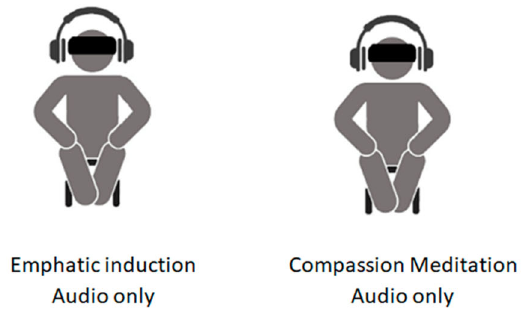
Figure 3. Phases of the audio condition.